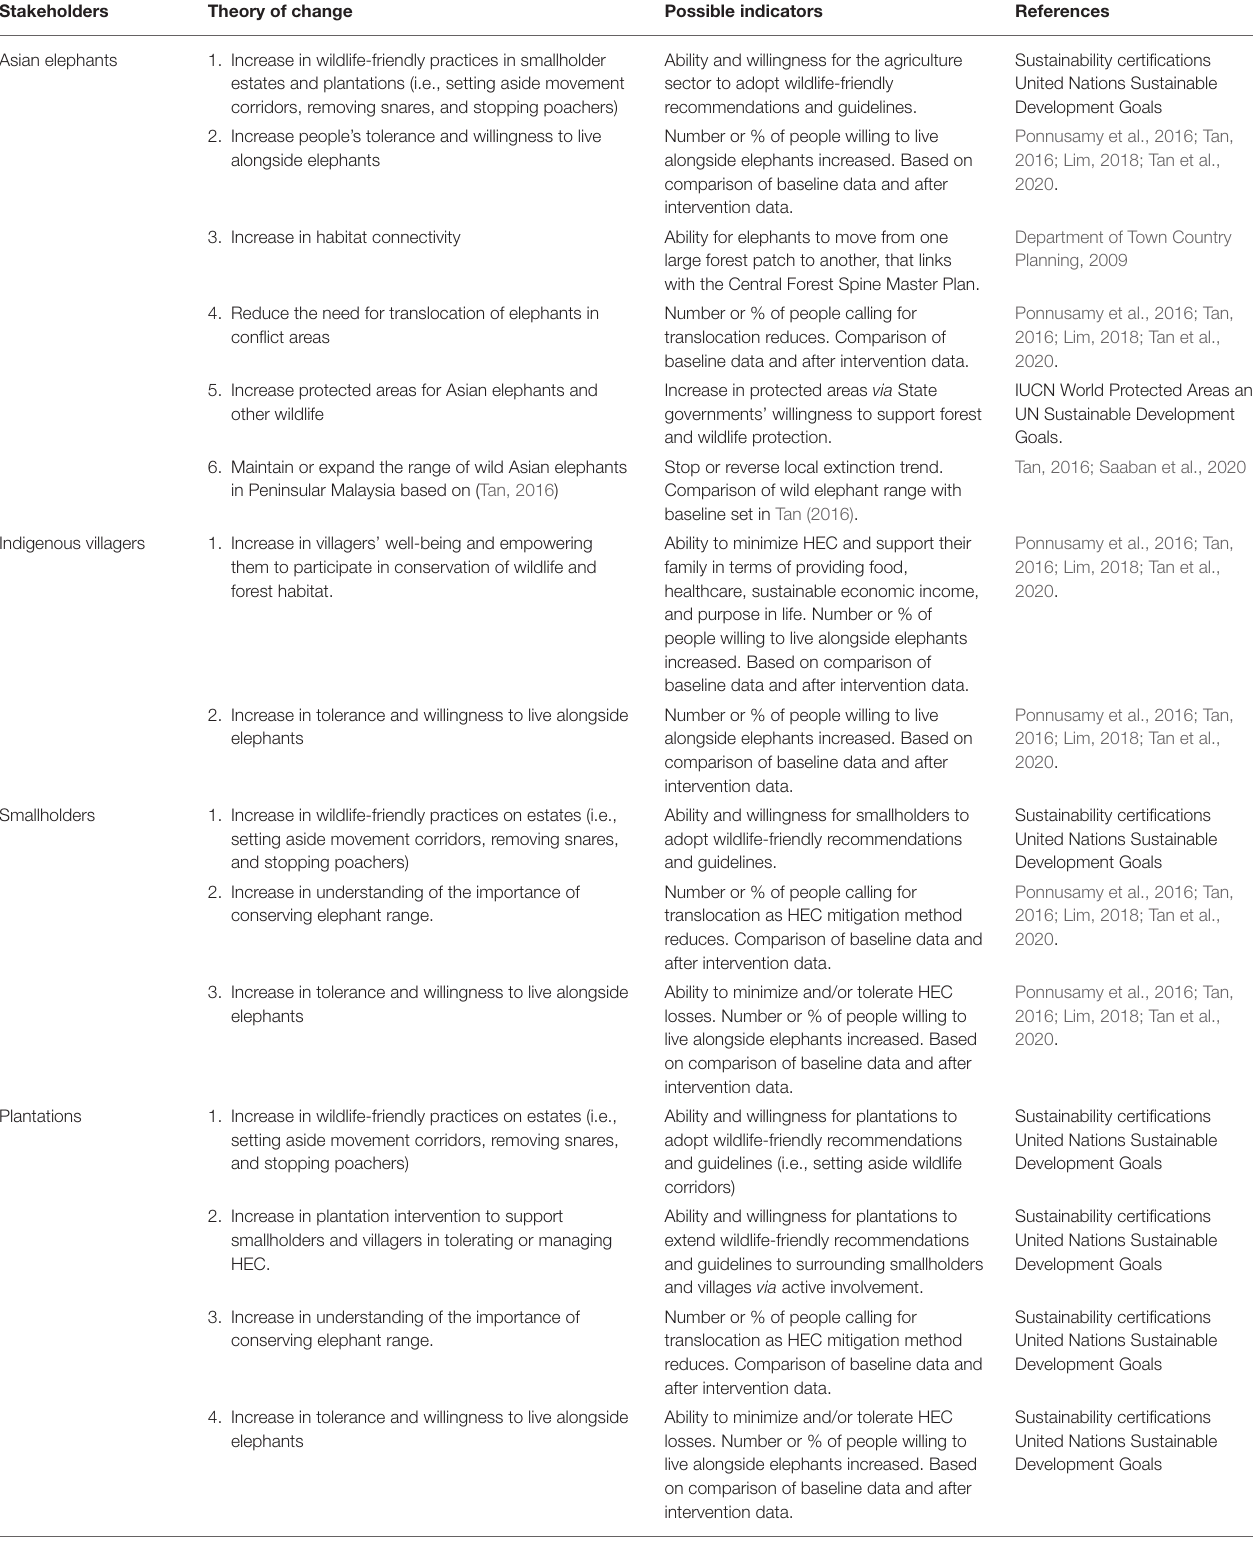
TABLE 2 | Stakeholders, theory of change, and possible